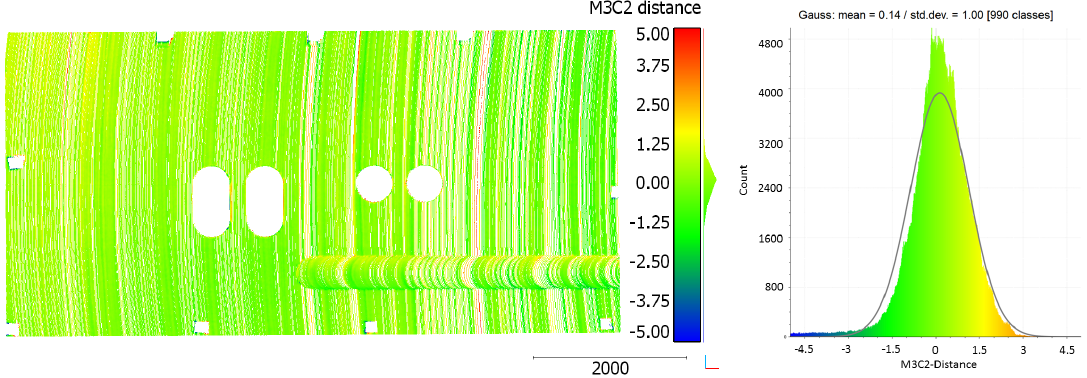
Figure 9. Computed 3D distance (M3C2) between s-TLS and k-TLS with iEKF